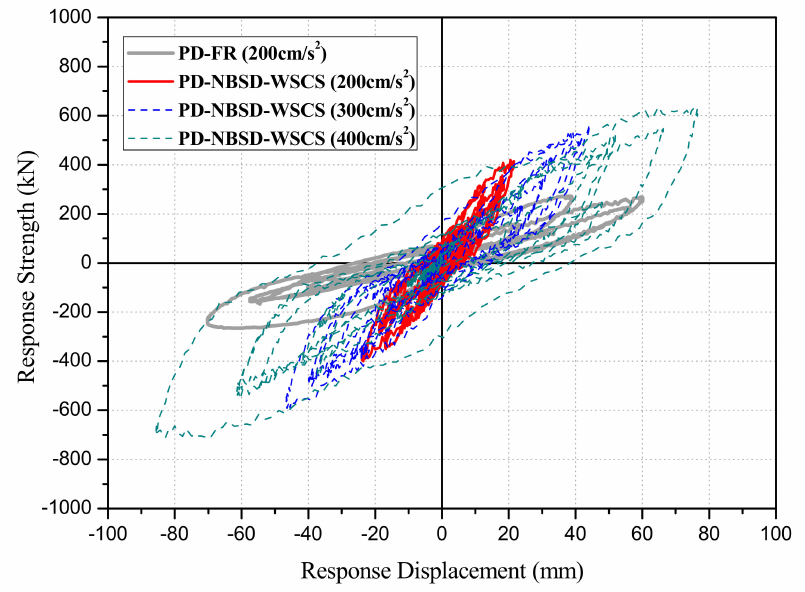
Figure 20. Comparison of seismic response shear stress–displacement curves.